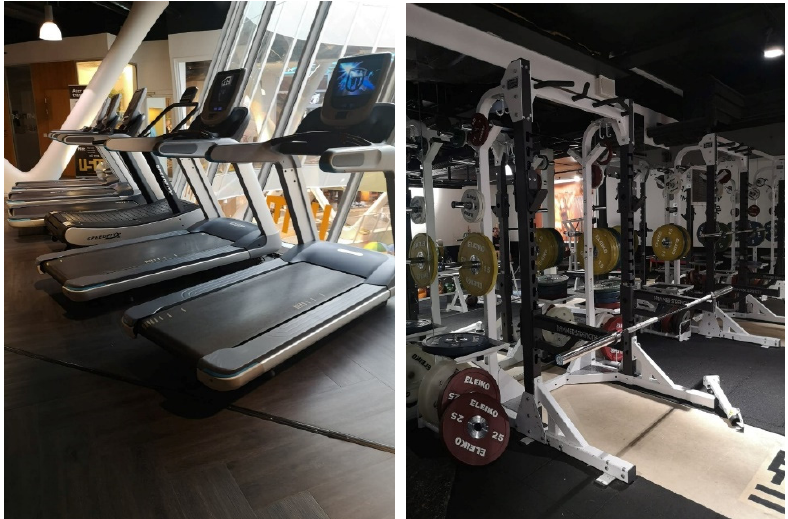
Figure 5. Umeå Sport & Motion Utopia, Sweden.